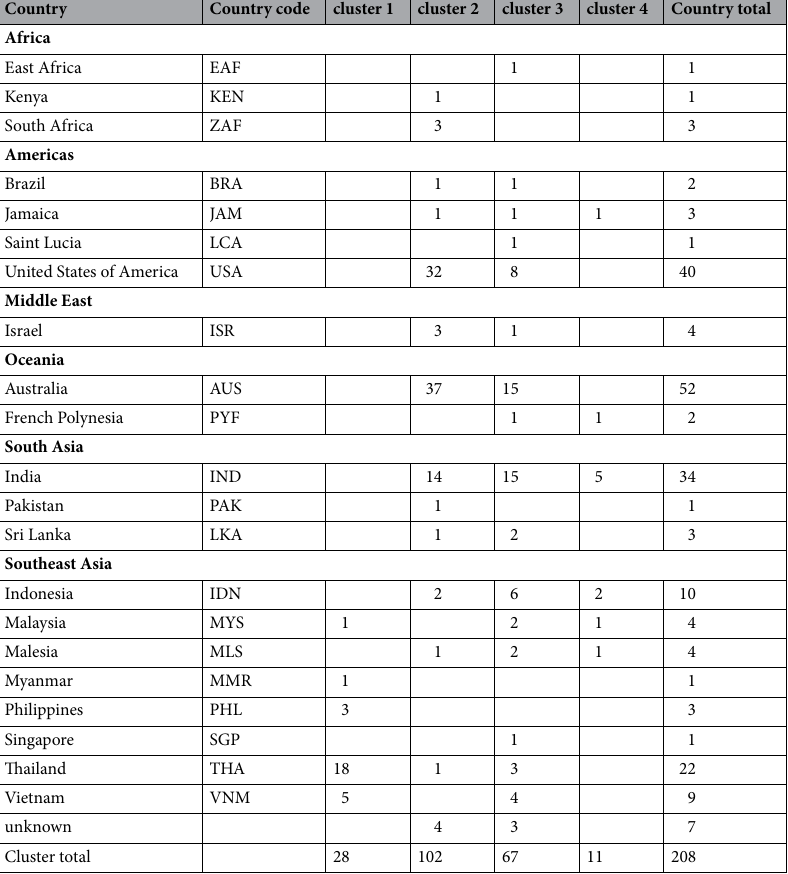
sorted across geography. Genetic differentiation comparisons showed variable patterns of F ST between genetic clusters and between regions of import. Comparisons between regions have low levels of F ST , which range from − 0.016 to 0.112 (Table 3a). Southeast Asia and the Middle East, closely followed by the comparison between Southeast Asia and the Americas, showed the highest level of genetic differentiation (F ST = 0.112 and 0.107, respectively). In contrast, F ST between clusters ranged from 0.051 to 0.286, with cluster 1 comparisons having the highest values (Table 3b). Overall, there is low genetic divergence amongst regions of the Australian mango gene pool and high genetic divergence between genetic clusters.